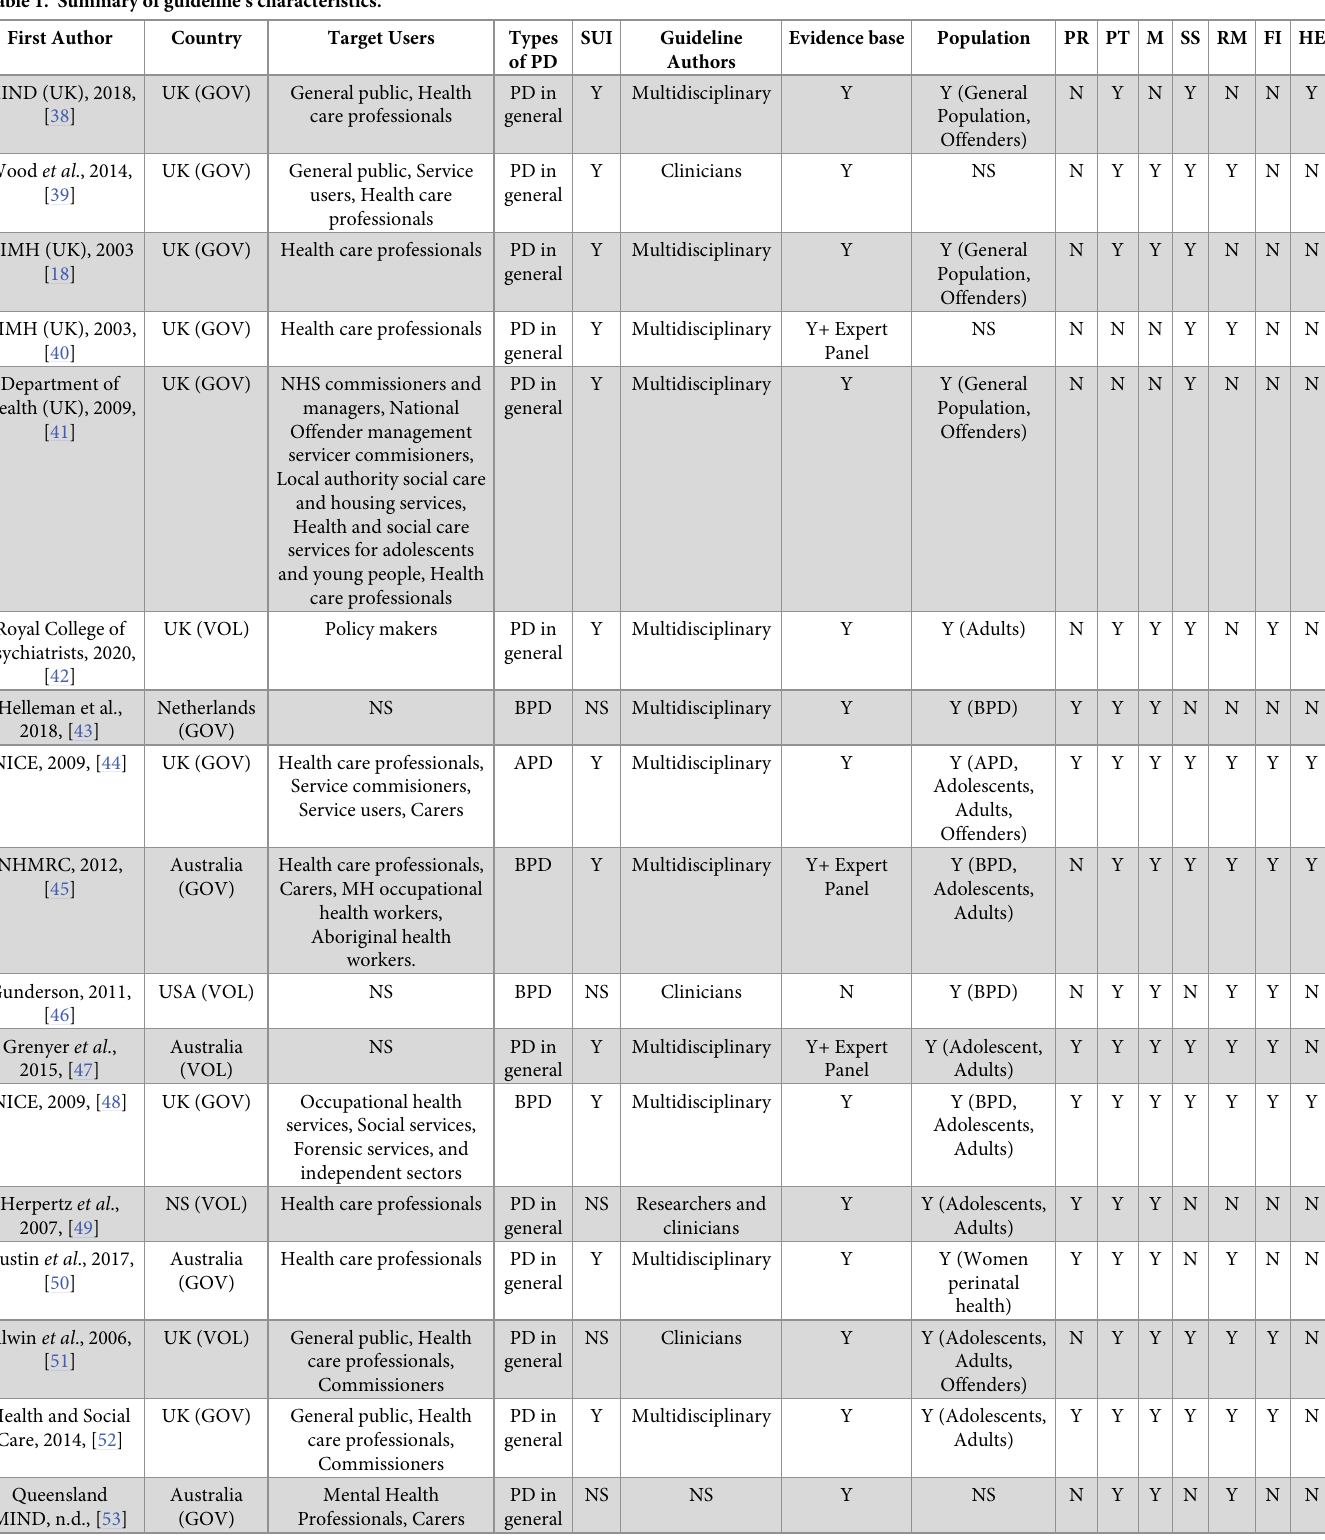
Table 1. Summary of guideline’s